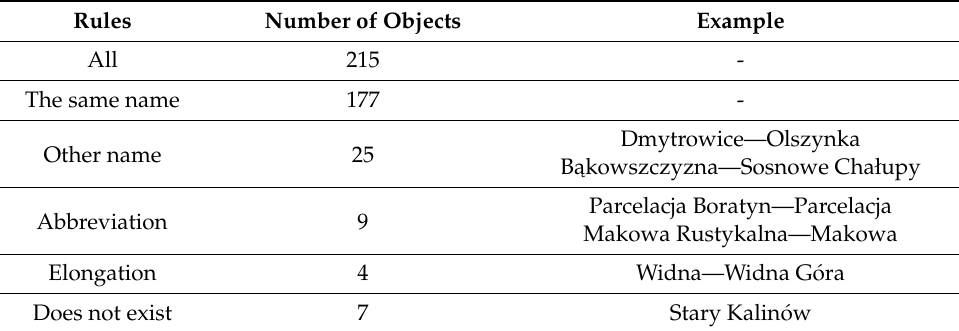
Table 1. Changes of Polish names (source: own